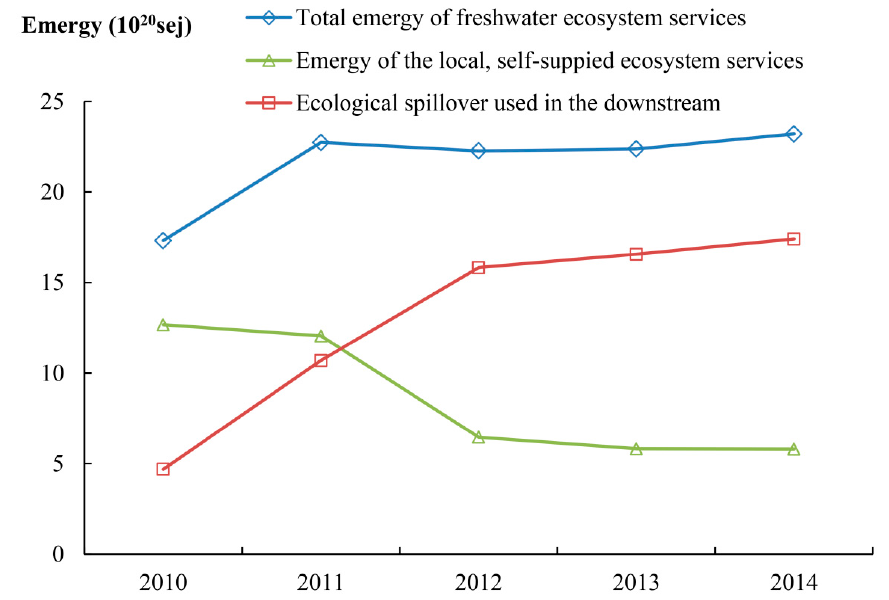
Figure 6. Annual values and trends of the amount (emergy) of ecological spillover used by Xuchang, the total emergy of freshwater ecosystem services and the emergy of self-supplied ecosystem services from 2010 to 2014. The results were extracted from Tables 1 and 2.